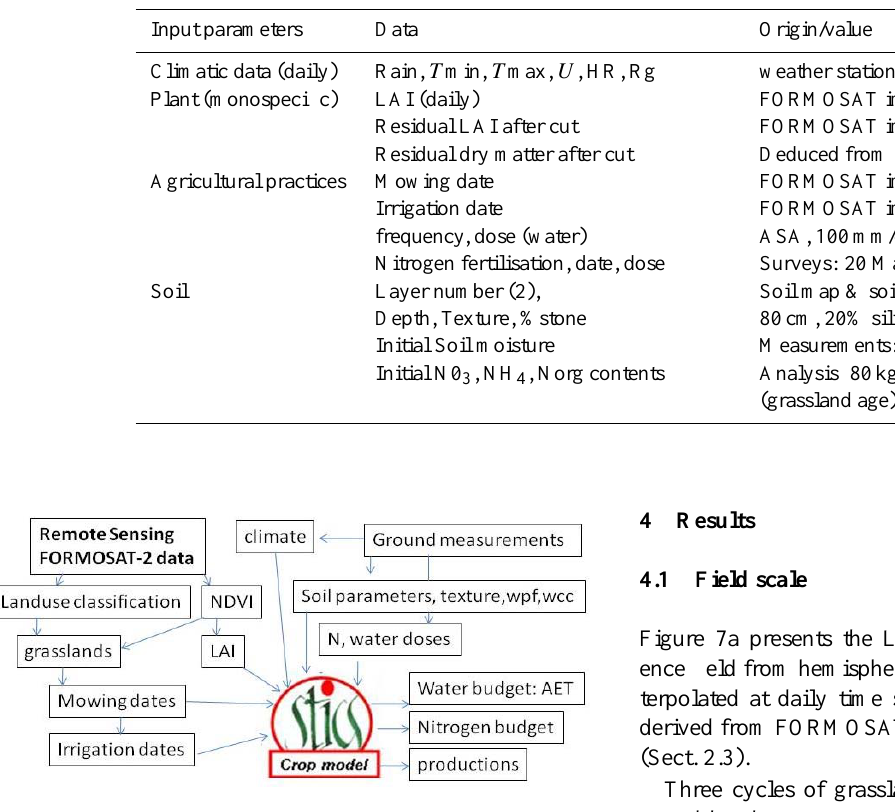
Fig. 6. Approach proposed to couple remote sensing data acquired at fine resolution and STICS crop model for assessing yields and water budgets at regional scale, (wpf: soil moisture at wilting point, wcc: at field capacity, N:nitrogen).